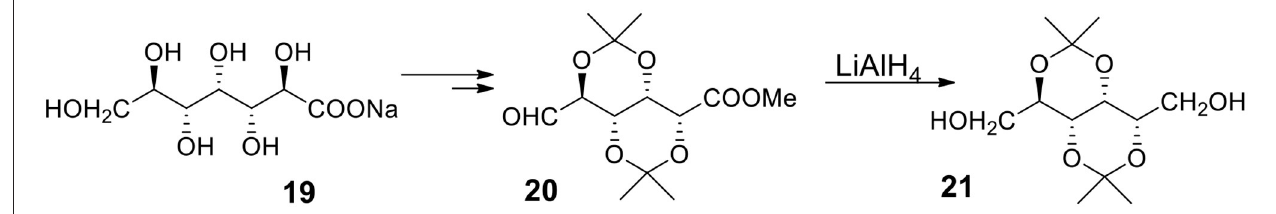
FIGURE 7 | Attractive diol synthesized from glucoheptanoic acid.